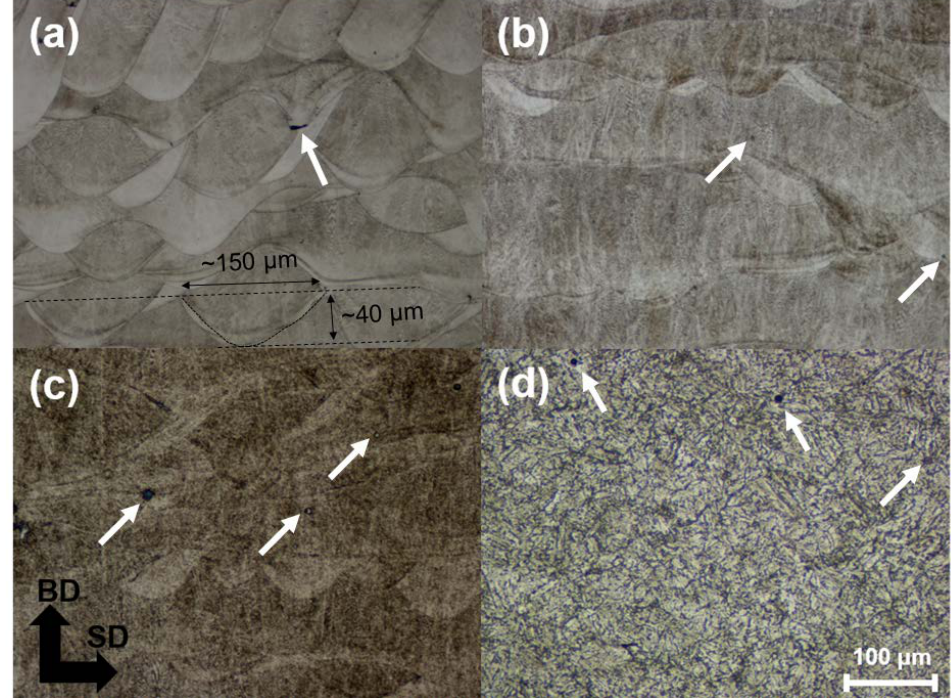
Figure 5. OM images of maraging steel samples (×200): ( a ) as-built condition; ( b ) after 6 h aging at 450 °C without ST; ( c ) after 750 °C ST for 2 h and aging at 450 °C for 6 h; and ( d ) after 850 °C ST for 2 h and aging at 500 °C for 6 h.